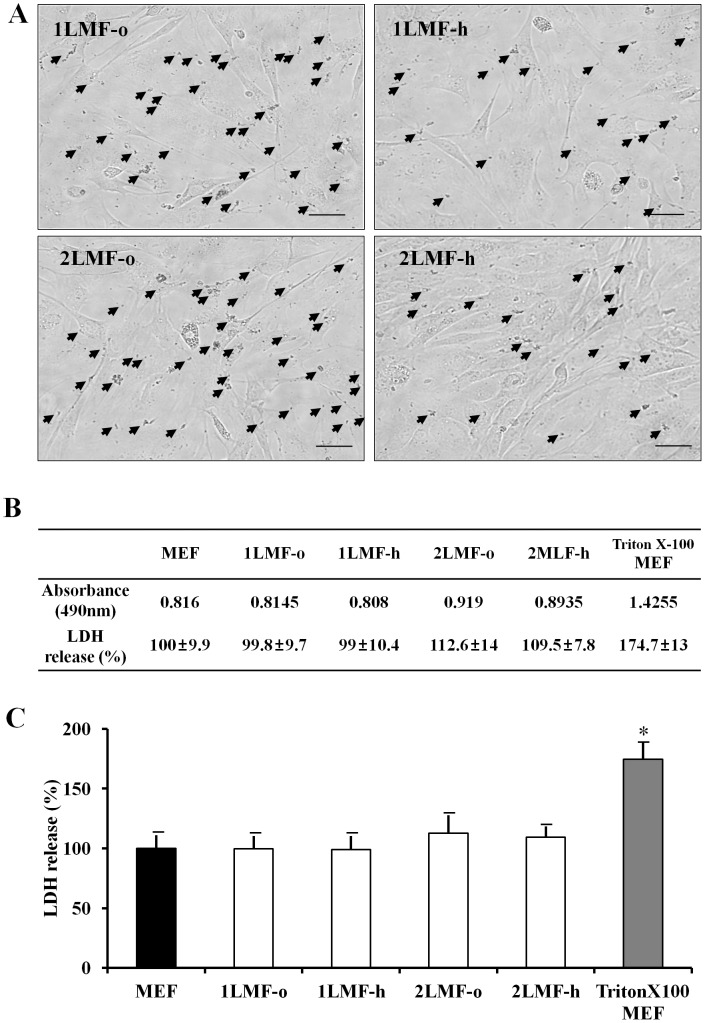
Cytotoxicity determination of MEF cells after LMF.(A) Liposomal magnetofection particles (arrows) in MEF cells at 24 hr post-LMF with either one or two LMF procedures and with different DNA doses (o: 1.5 µg, h: 0.75 µg). (B and C) The colorimetric absorbance values and LDH release percentages for control MEF cells, the four LMF treatment groups (1LMF-o, 1LMF-h, 2LMF-o, and 2LMF-h) at 24 hr post-LMF, and triton X-100–exposed MEF cells.